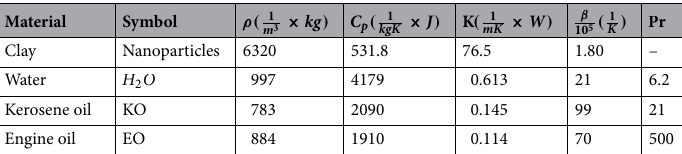
Table 1. Thermophysical properties of nanofluids 59